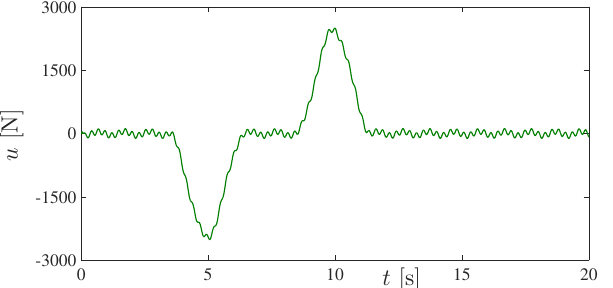
Figure 7. Active control force applied to the vehicle suspension system using online estimation of velocity and disturbance signals.